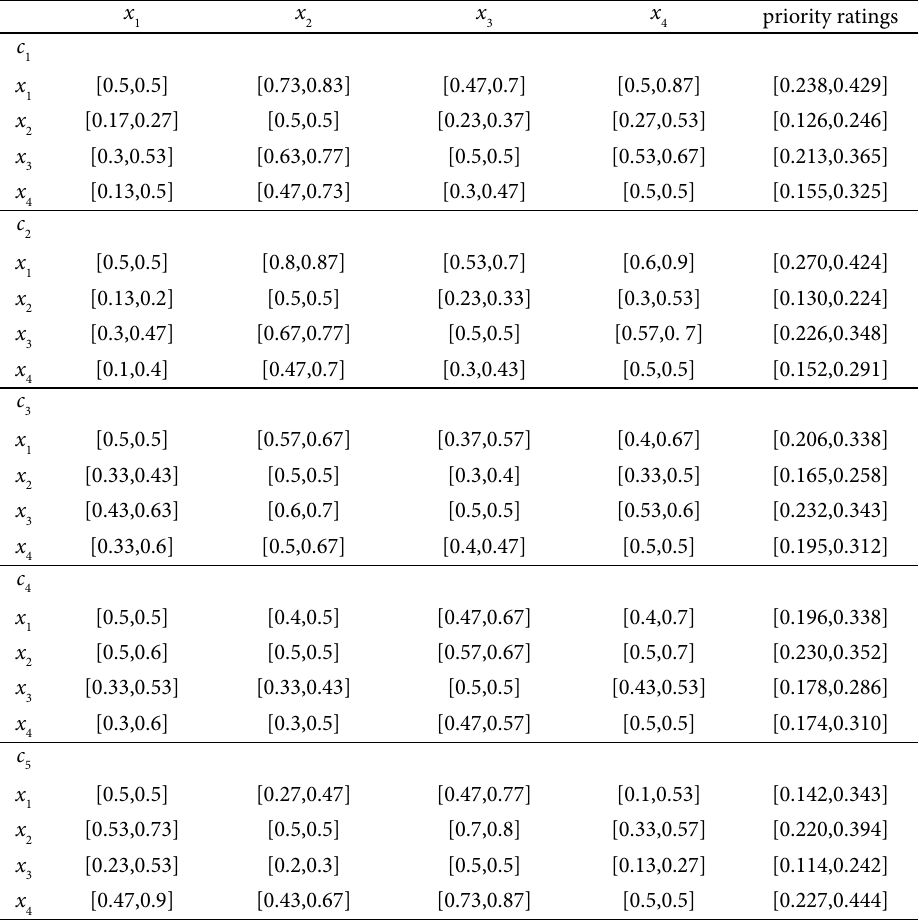
Table 2. Collective interval additive preference relations and their priority ratings x 1